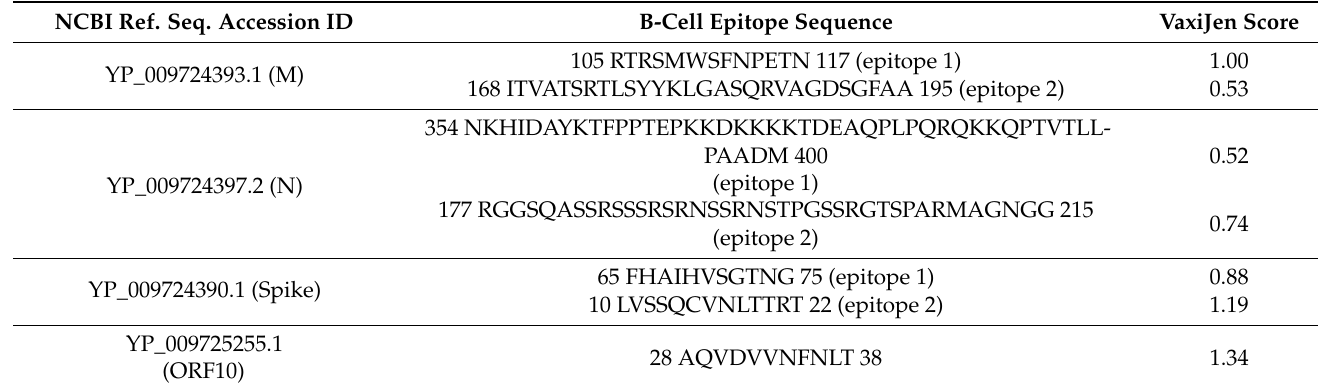
Table 3. B-cell epitopes of SARS-CoV-2 and their corresponding antigenicity scores. NCBI Ref. Seq. Accession ID